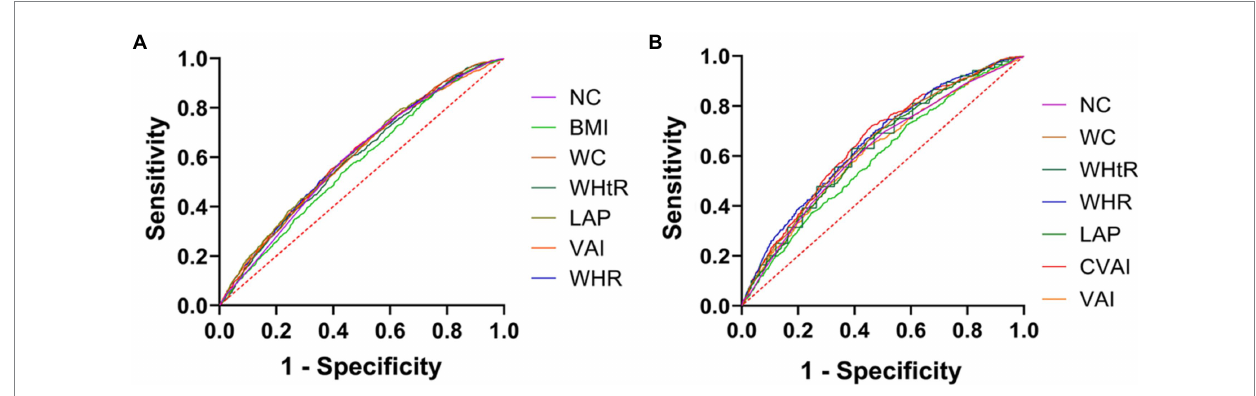
FIGURE 1 Anthropometric indices ROC curves for the diagnosis of DM in men and women. (A) ROC curves of indicators of abdominal obesity and diabetes in women. (B) ROC curves of indicators of abdominal obesity and diabetes in women.